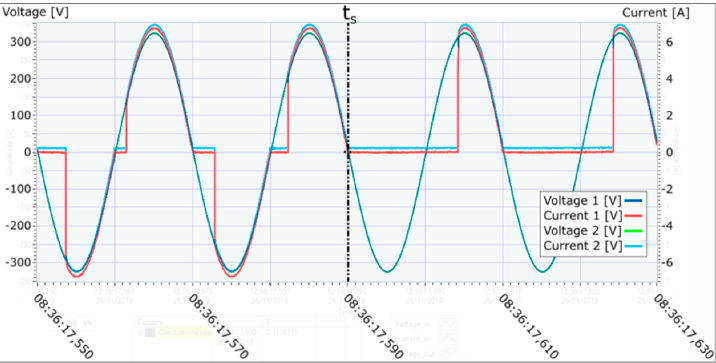
Figure 21. Instant ( t s ) when the current began to flow only in the positive half-waves (using the Bourns 2049-25 surge arrester).